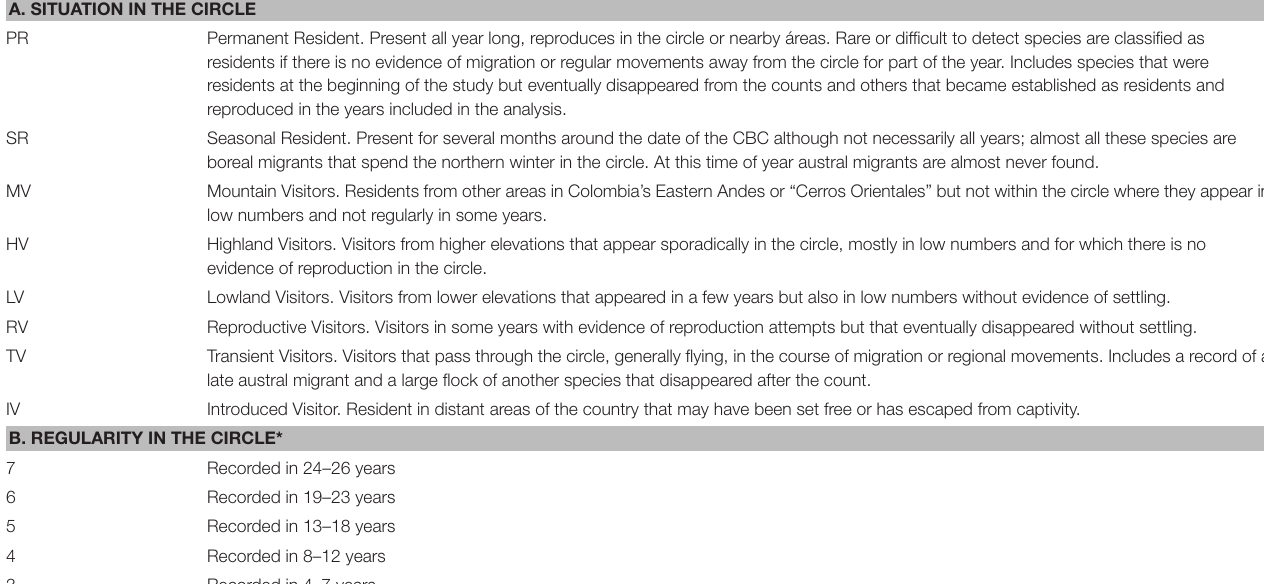
TABLE 2 | Classification of species registered in the Audubon’s Christmas Bird Counts in the Sabana de Bogotá circle,